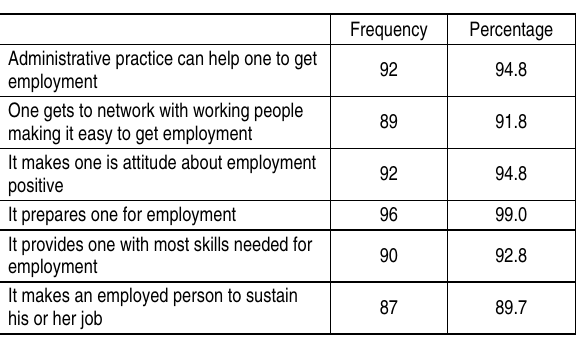
Table 1. Frequency of students’ overall impression of the experiential learning project in administrative